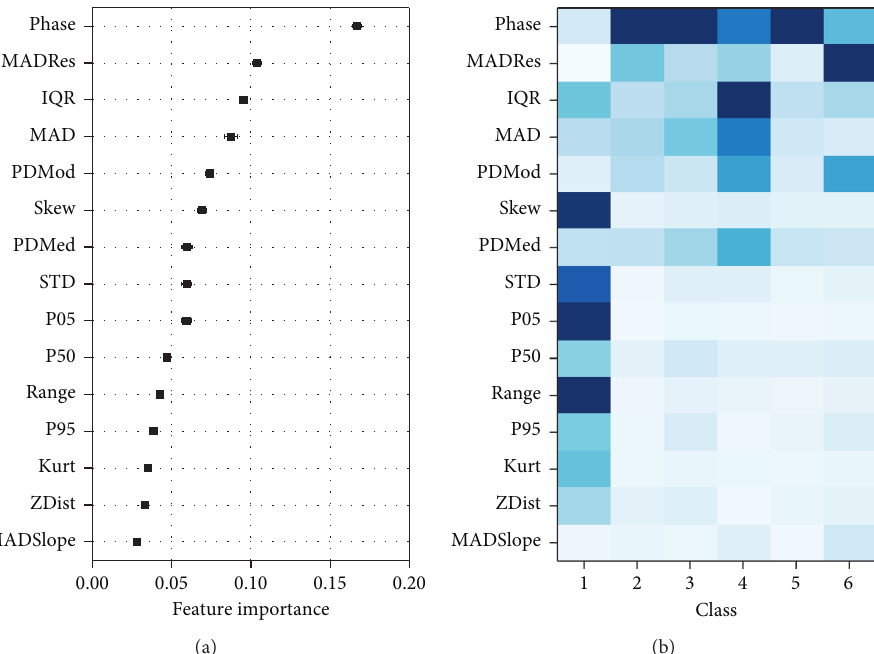
Figure 3: Feature importance produced by Random Forest Classifier for multiclass case (a) and binary classification case (b). In the right panel, features with higher importance are represented by darker colors.